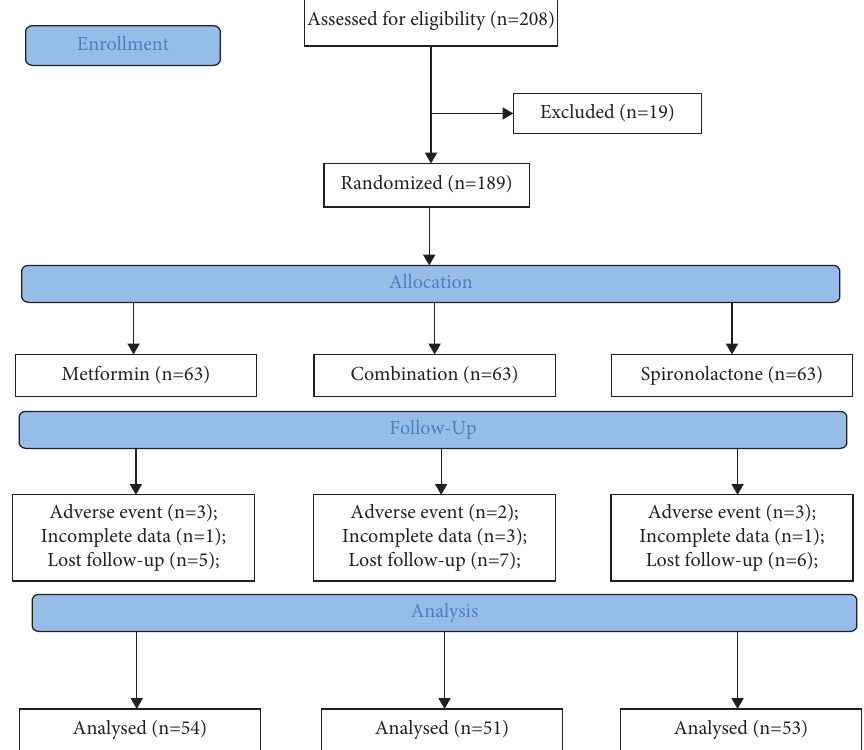
Figure 1: Participant